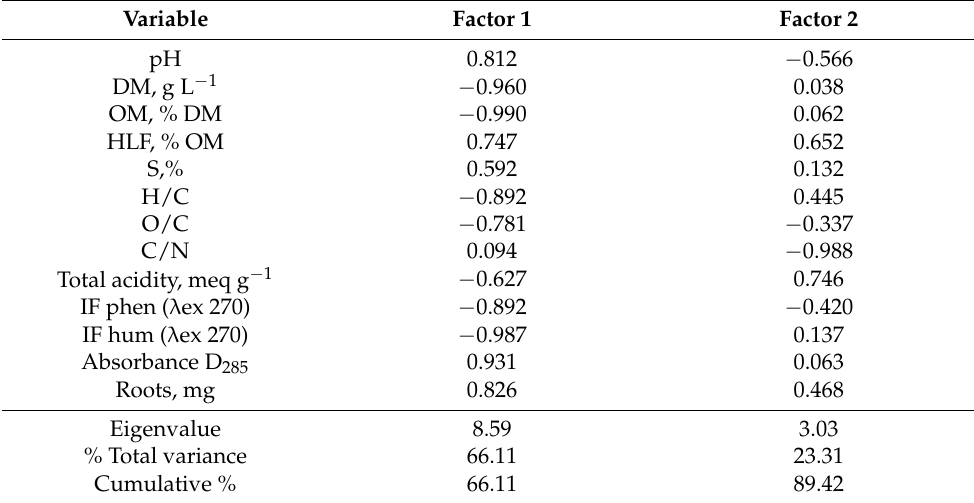
Table 2. Factor coordinates of the variables, based on